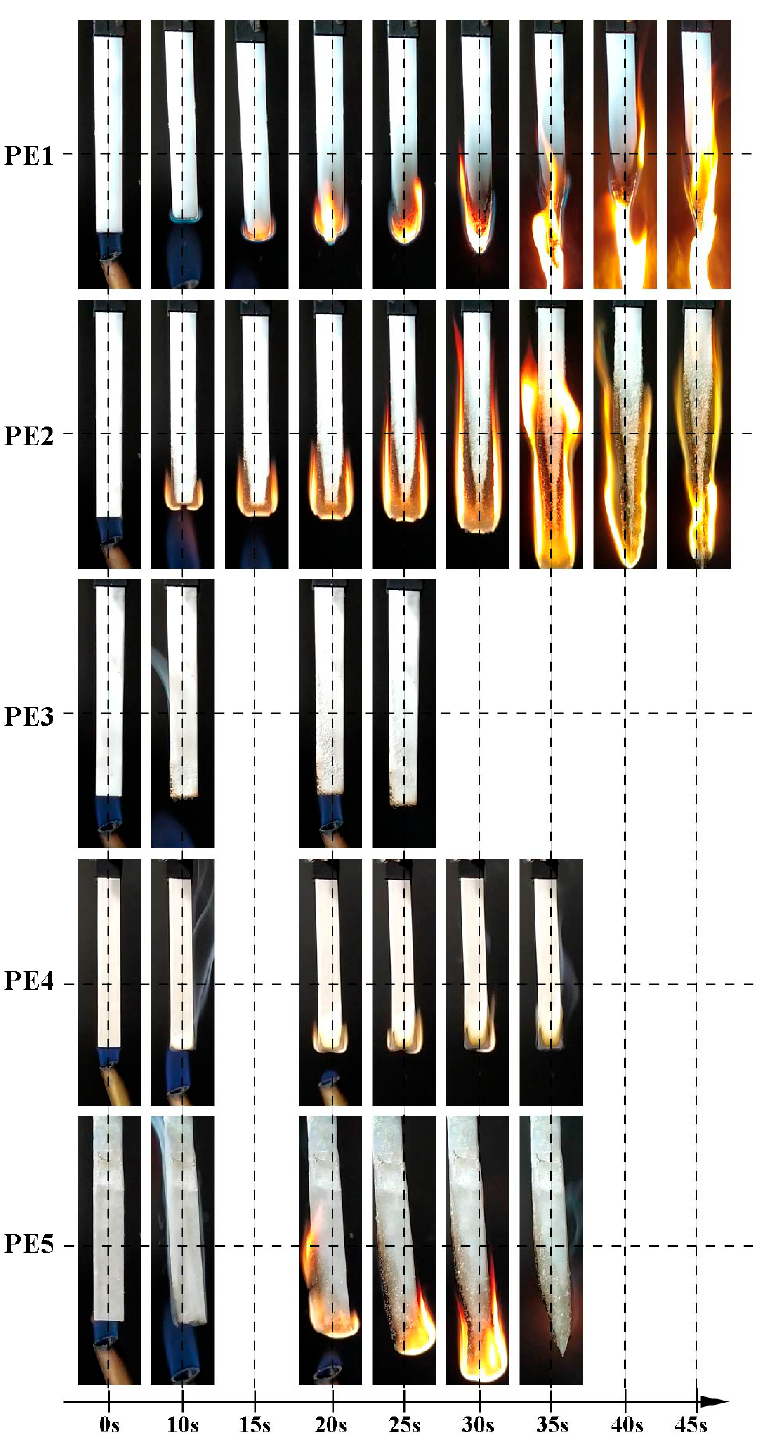
Figure 4. Photos of UL-94 test for HDPE and HDPE/IFR composites.